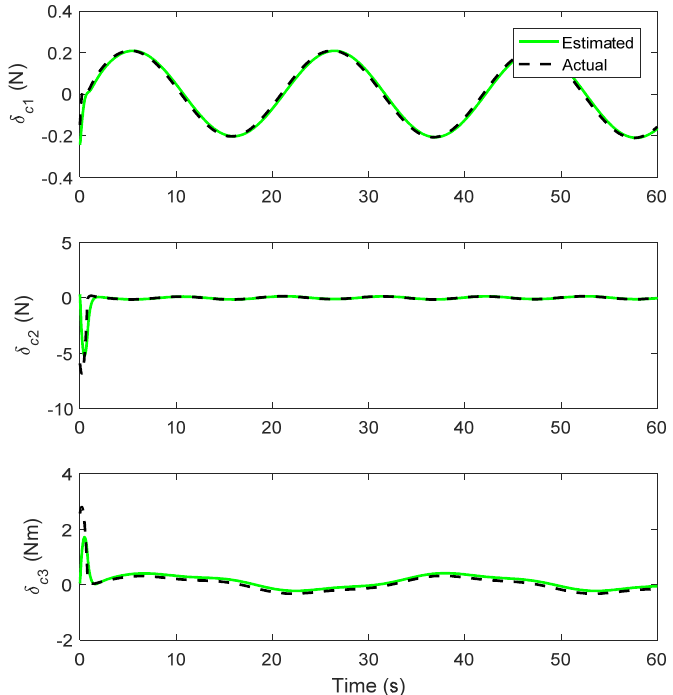
Figure 18. Matched lumped disturbance and estimation (Case 2).